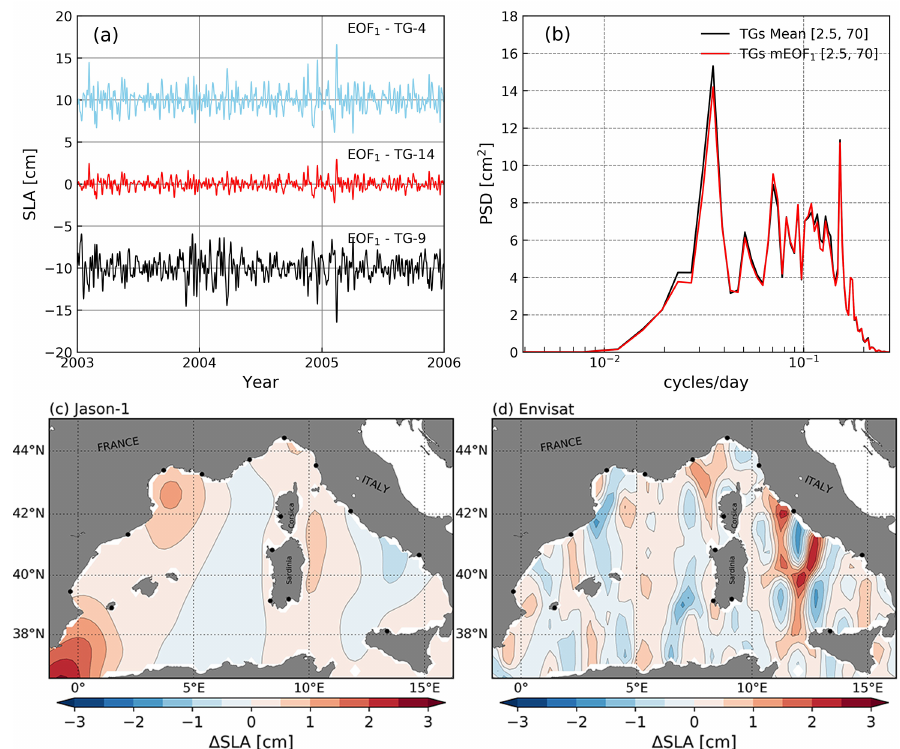
Figure 5. ( a ) A [2.5, 70] day band-pass filtered common mode calculated by the EOF 1 at TG-4, TG-9 and TG-14. ( b ) The variance-preserving spectra of a [2.5, 70] day band-pass filtered common mode from the TGs by spatial average method (black line) and mean EOFs (red line). ( c , d ) The mean differences (color bar) of corrected SLA produced by spatial average method and EOF analysis method at Jason-1 and Envisat along-track data, respectively. The black dots stand for the location of TG